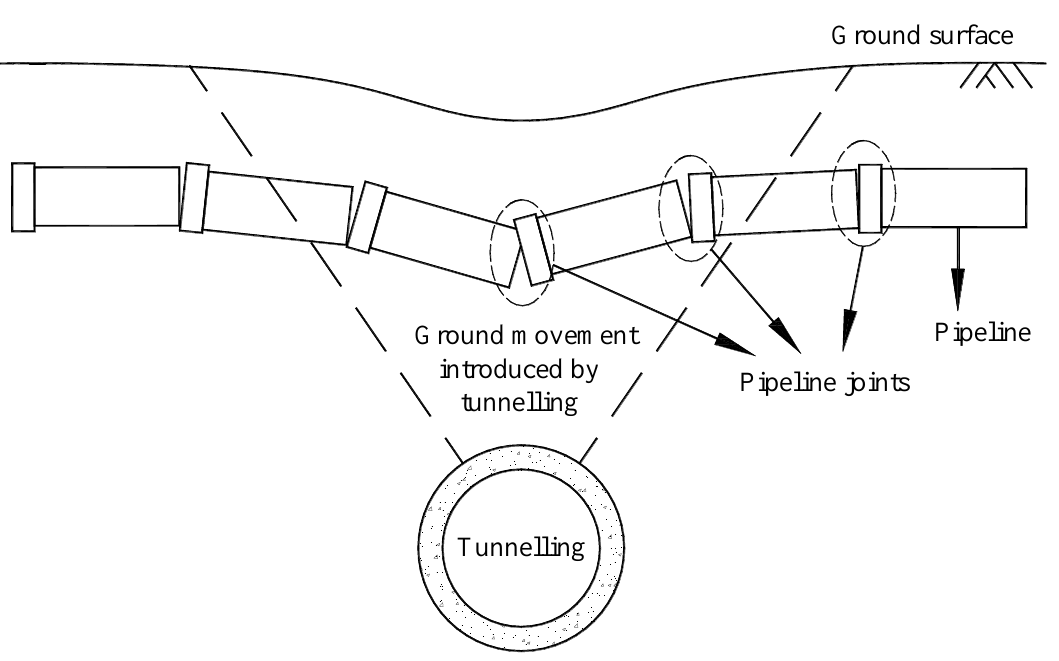
Figure 1. Typical deformation of buried jointed pipeline subjected to tunnelling-induced ground settlement while the joints are in the least helpful positions.